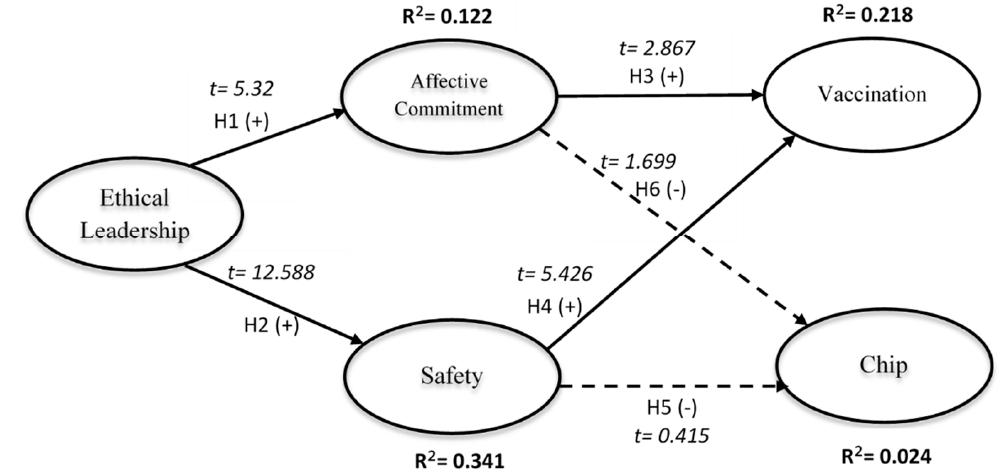
Figure 1. Structural Model that illustrates variable relationships in this